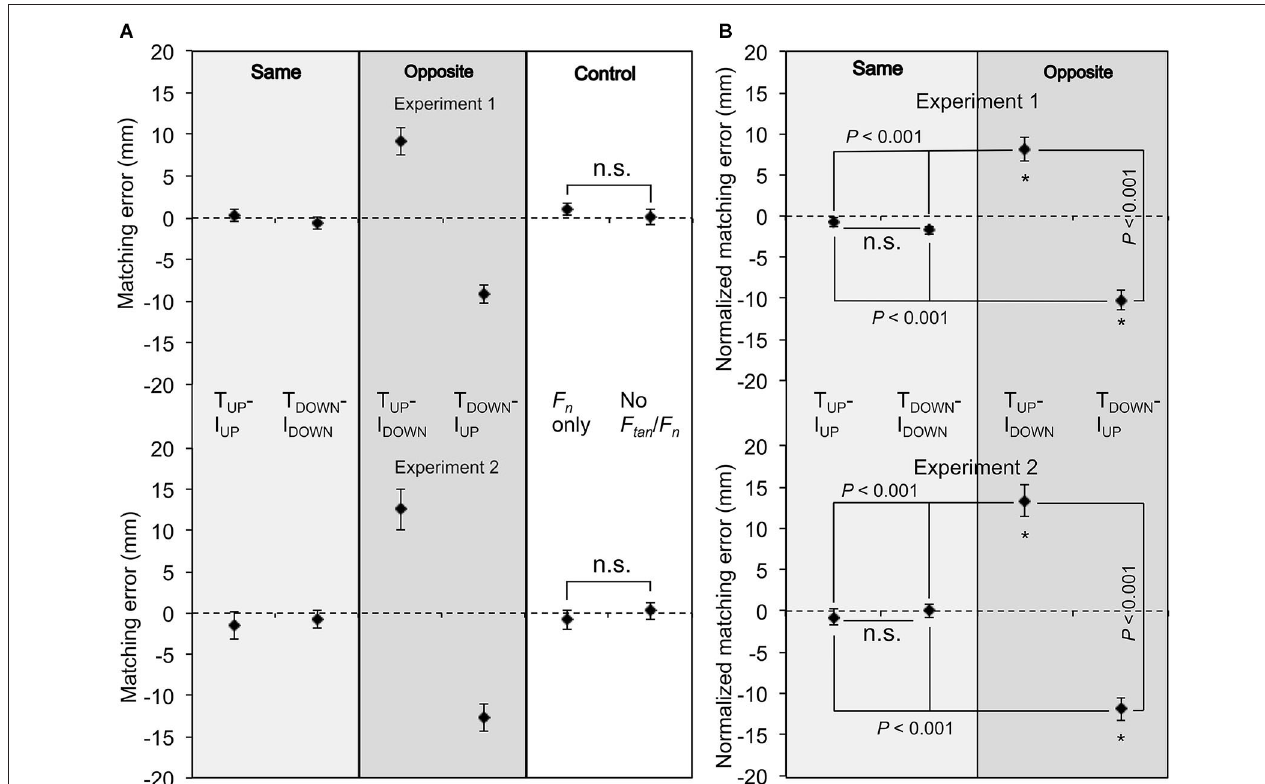
respectively; see text for more details). (B) shows average normalized matching error for the Experiments 1 and 2 (top and bottom plots, respectively) across matching conditions. For all panels, matching and normalized errors were averaged across all subjects (vertical bars denote SE). Asterisks denote significant differences ( p < 0.05) from zero, whereas “n.s.” denote non-significant